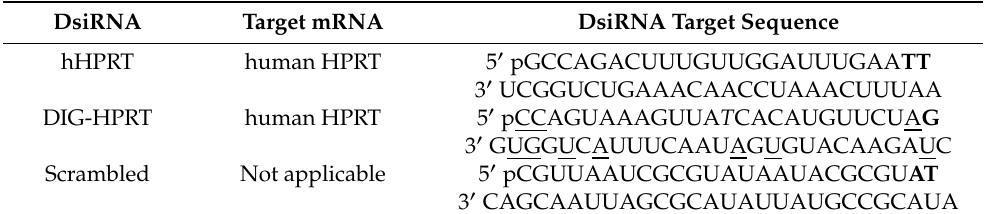
Table 1. Sequences of DsiRNA used in the study. DNA bases are in bold and 2 O’ methyl bases are underlined. Amino dT bases coupled to DIG are in italics. DsiRNA Target